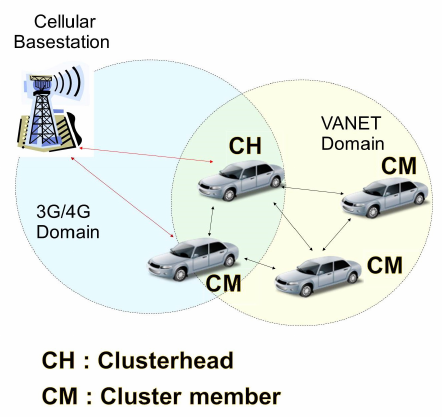
Figure 6. A typical social cluster and the corresponding cluster head of E − SPC